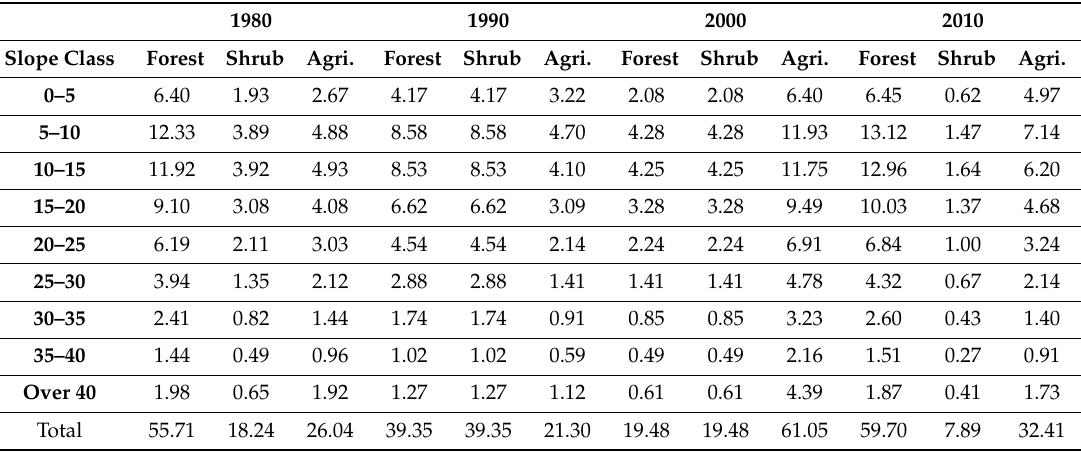
Table 10. Province 4: land use as a percentage of total area of forest, shrubland, and agriculture for 1980, 1990. 2000, and 2010 for entire Nepal. ((Individual land-use area for a slope class / sum of forest + shrubland + agriculture) * 100).